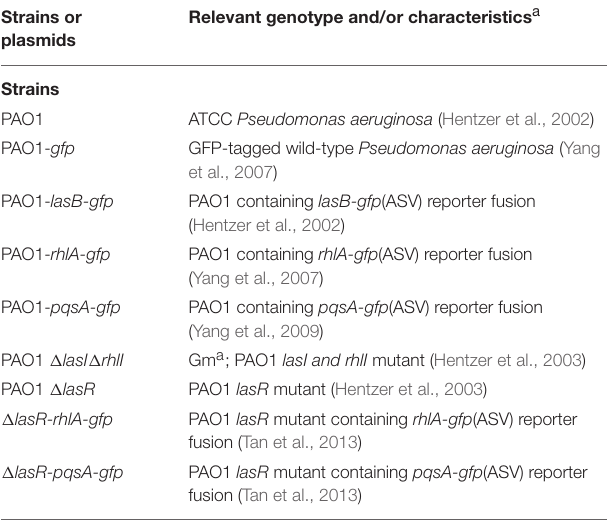
Relevant genotype and/or characteristics a